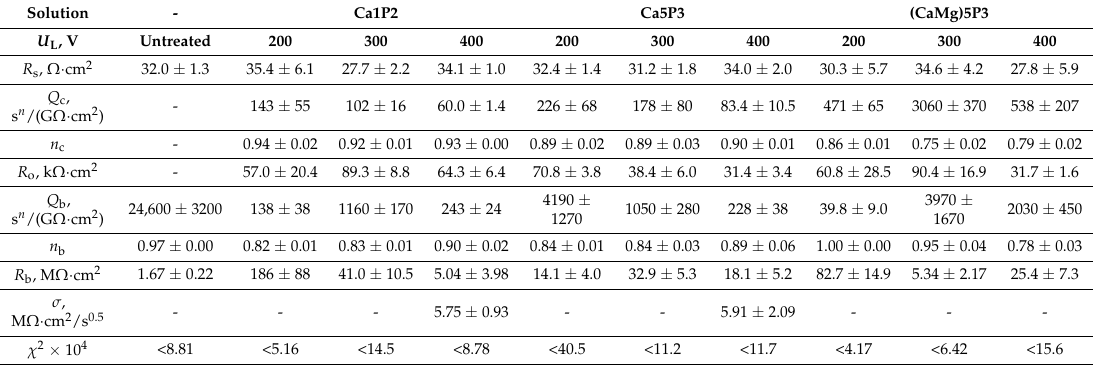
Table 1. Circuit parameters calculated from the fitting of the EIS spectra to the EECs from Figure 7. Solution -